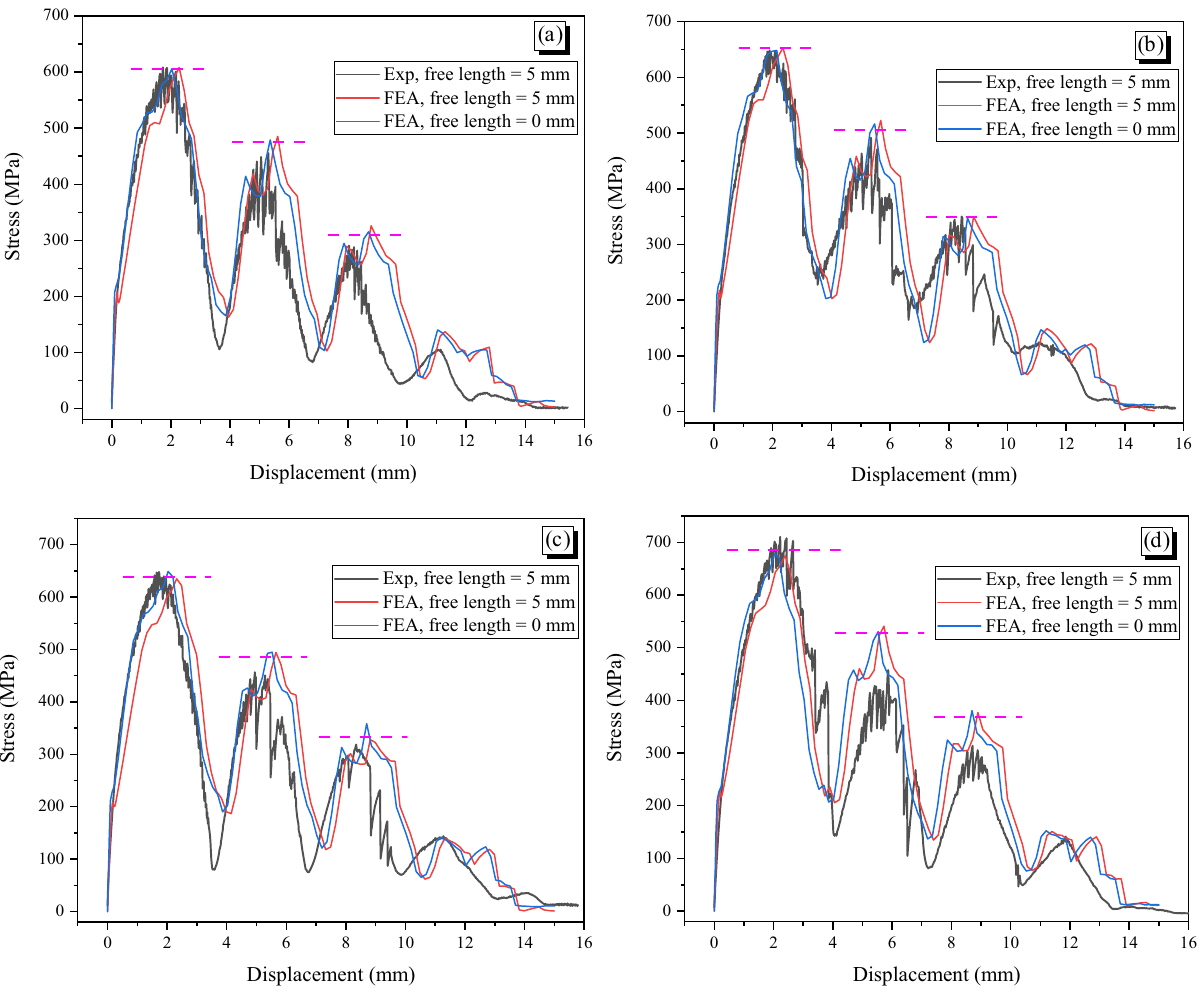
Figure 21: In fl uence of free length on the relationship between pullout stress and displacement: ( a ) wave depth = 0.055 mm, ( b ) wave depth = 0.061 mm, ( c ) wave depth = 0.091 mm, and wave depth = 0.124